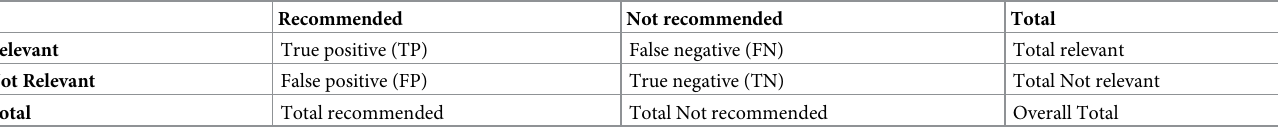
Table 5. Confusion matrix for